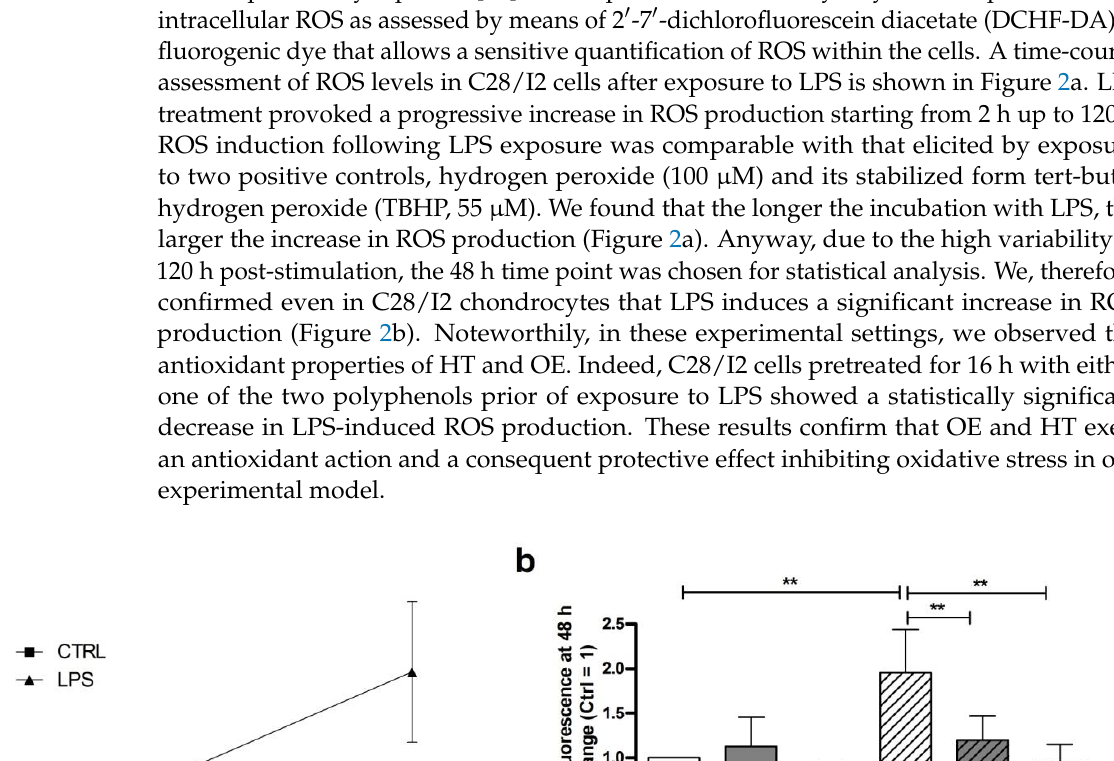
Figure 1. Effects of lipopolysaccharide (LPS) on inflammatory responses. mRNA expression of inflammation markers in primary chondrocytes ( a ) and C28/I2 chondrocytes ( b ) significantly increased 6 h after LPS stimulation. Data from cells treated with LPS (dashed pattern) were compared to appropriate control and obtained from the same set of samples (n = 13 to 15 different primary chondrocyte cultures or n = 5 for C28/I2). Quantification of expression levels was calculated for each target gene and normalized using the reference housekeeping gene GAPDH. Values obtained in chondrocytes were calculated according to the formula 2 −ΔCt and expressed as number of molecules per 100,000 GAPDH molecules. Results are means ± SEM. Statistical analysis was performed by Student’s t test for paired samples (* p < 0.05; ** p < 0.01; and *** p < 0.001).